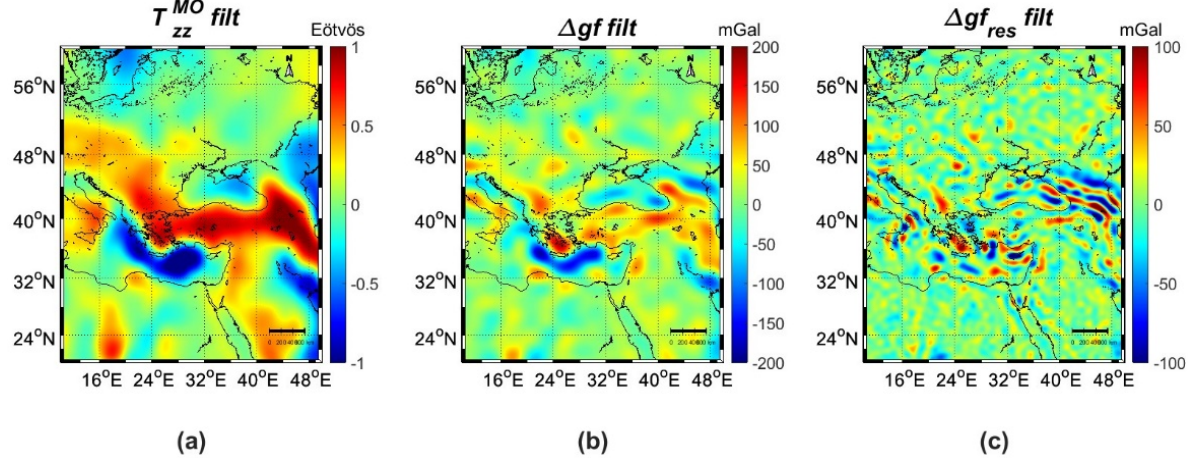
Figure 7. ( a ) The filtered synthesized T MO zz filt at MO = 230 km, ( b ) the DC free-air gravity anomalies